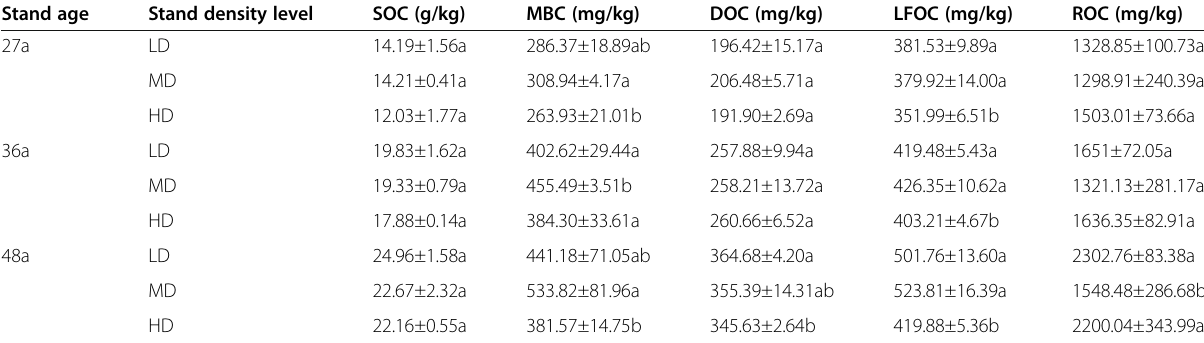
Table 3 Soil analysis results for SOC and labile organic carbon at 0 – 30 cm soil depth for different stand density levels. Values are the mean ± standard deviation (SD). Different lowercase letters (a, b, c) indicate significant differences between stand density levels ( P < 0.05). SOC, soil organic carbon; DOC, soil dissolved organic carbon; MBC, microbial biomass carbon; LFOC, light fraction organic carbon; ROC, readily oxidized carbon. 27a, 27-year-old stand; 36a, 36-year-old stand; 48a, 48-year-old